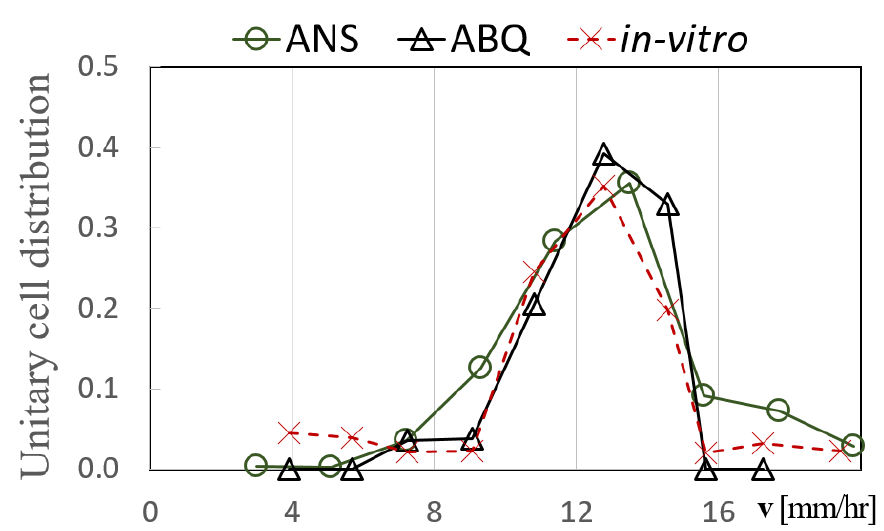
Figure 2. Distribution of mean cell sedimentation velocity per unit cell. The results obtained were compared to the in vitro results (red). The results of the ANS model showed a wider cell sedimentation velocity due to variational inertial forces and a non-homogeneous cell diameter (MSE = 0.0029), while the ABQ model revealed a lower distribution of the cell velocity due to the more homogeneous conditions considered (MSE =